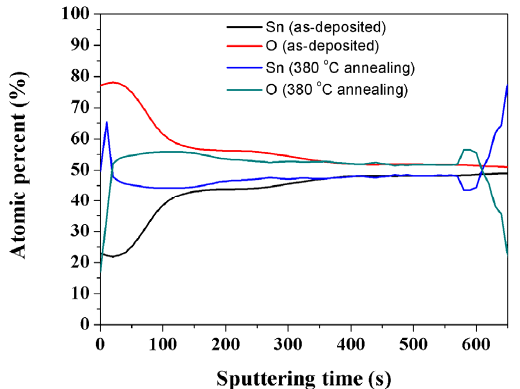
Figure 6. Atomic depth profile of the as-deposited and 380 °C annealing SnO 2 − x thin